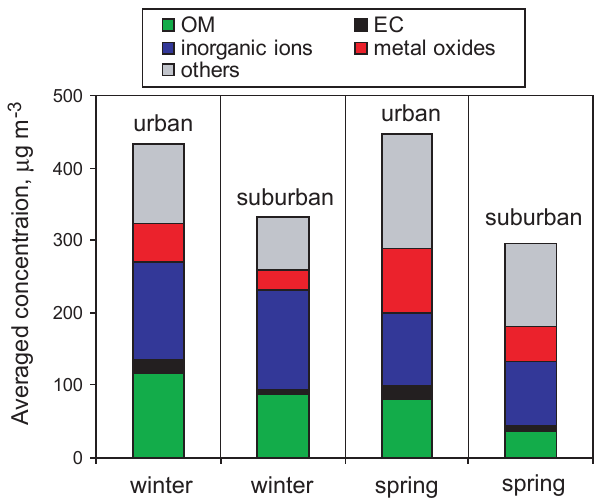
Fig. 5. Concentrations of major components determined in the PM 10 of Baoji City (Data of inorganic ions are cited from Wang Fig. 5 Concentrations of major components determined in the PM 10 of Baoji City et al. (2010)).